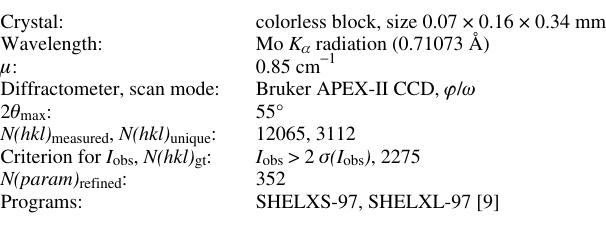
Table 1. Data collection and handling.